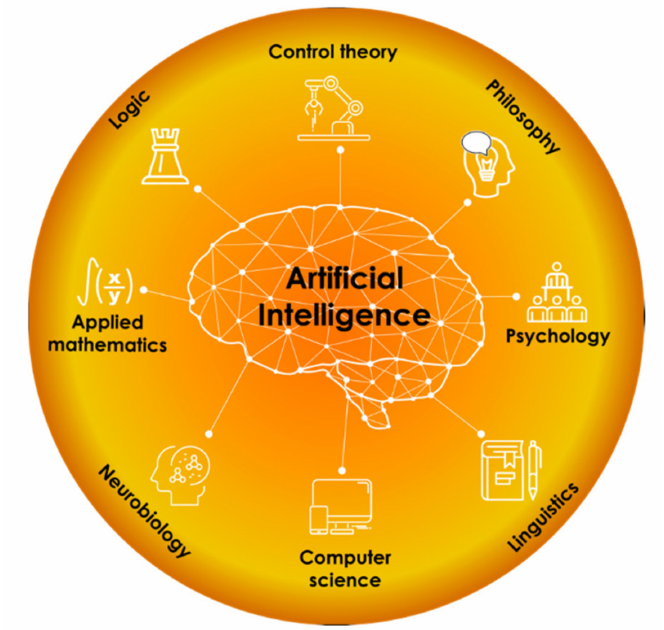
Figure 1. Artificial intelligence (AI) at the “science